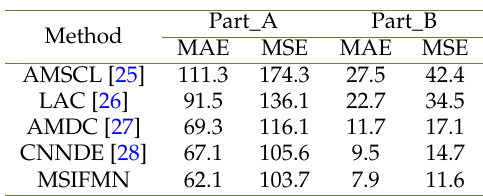
Table 1. Comparison with other state-of-the-art methods on ShanghaiTech